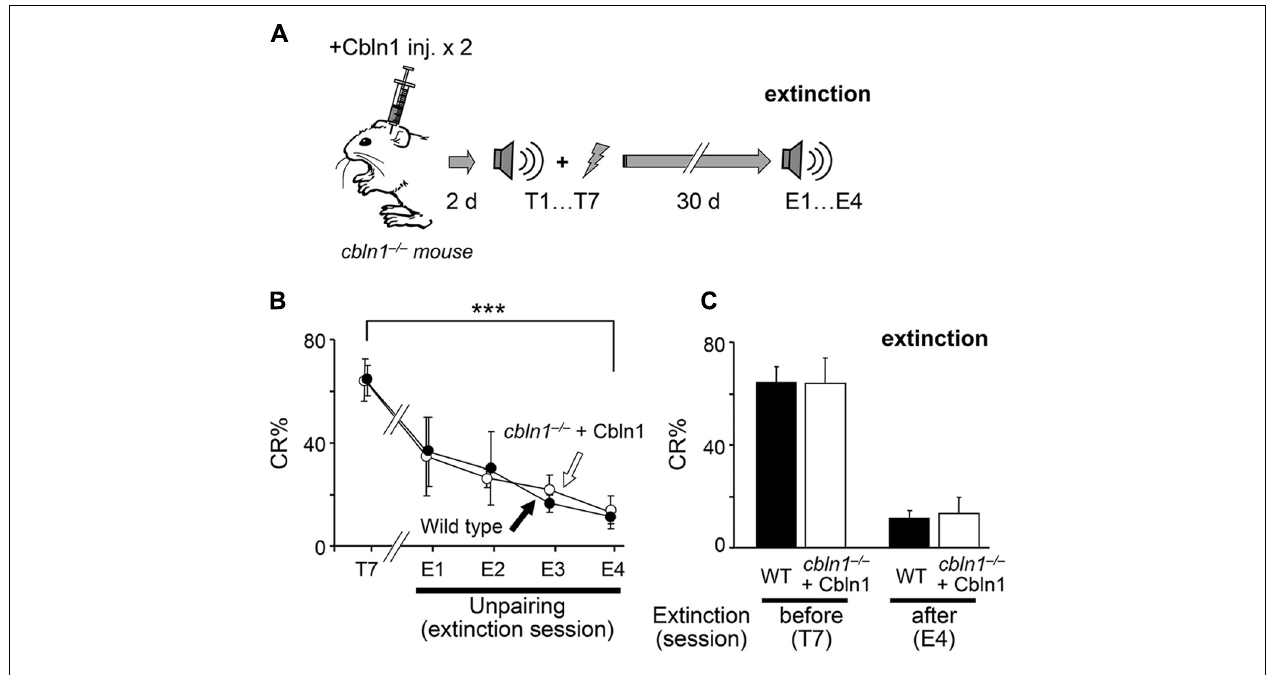
both wild-type mice ( n = 7) and cbln1 − / − mice injected with Cbln1 ( n = 7; *** p < 0.01, T7 vs. E4 in each group, by Mann–Whitney’s U test). During extinction sessions (E1–E4), no difference in CR% was observed between wild-type mice and cbln1 − / − mice injected with Cbln1 ( p > 0.1, a two-way repeated measures ANOVA, n = 7 for each group). (C) The CR% was similar between wild-type mice and cbln1 − / − mice injected with Cbln1 at E4 as well as at T7 ( p > 0.1, by Mann–Whitney’s U test, n = 8 for each